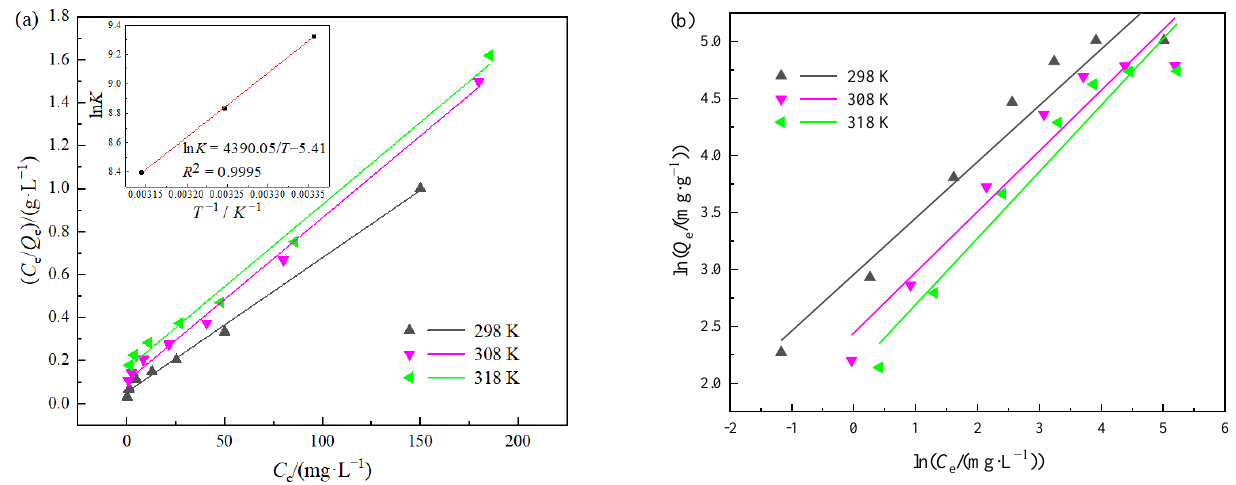
Figure 8. ( a ) Langmuir and ( b ) Freundlich adsorption isotherms for the adsorption of phenol on S2.